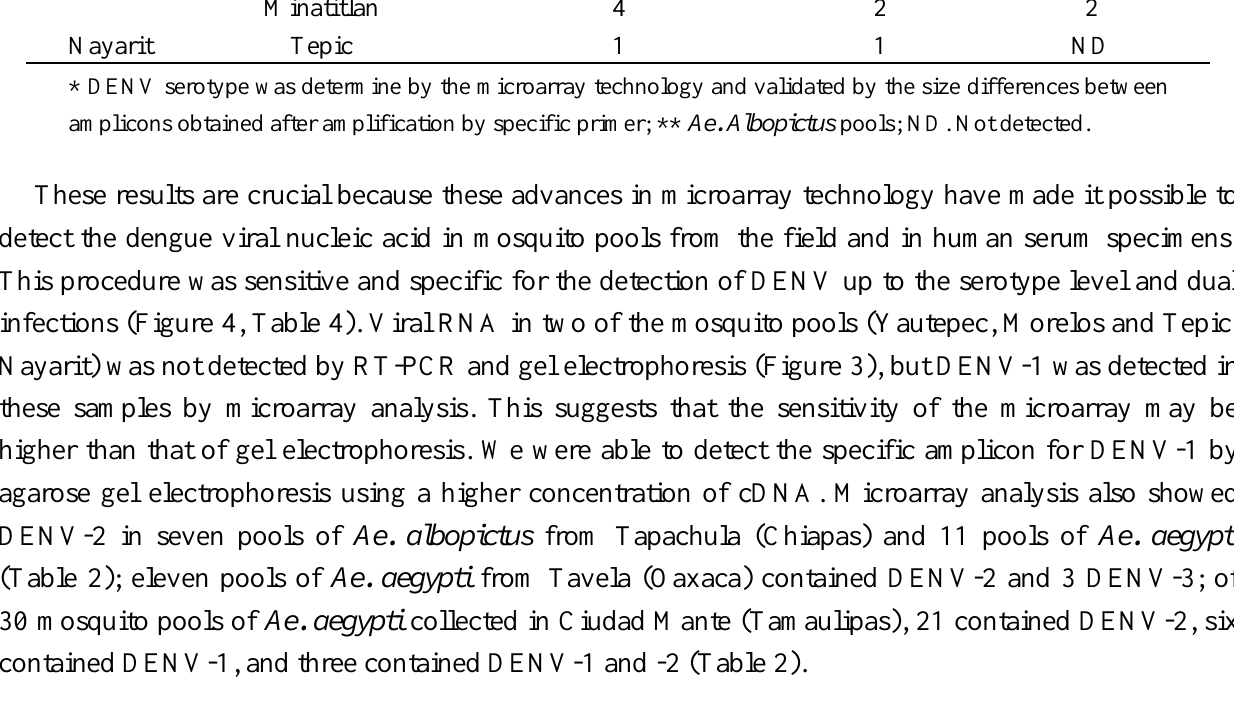
Figure 5. Samples were evaluated for the presence of dual serotypes. Panels ( a )–( c ) represent fluorescence for DENV-4, -3, and -1; ( d ) corresponds to DENV-1 (Texas Red), DENV-2 (FAM), DENV-3 (Cy5) and DENV-4 (Yakima yellow) serotype controls; and ( e ) shows the merged images of DENV-1 and -4, DENV-2 and -4, and DENV-3 and